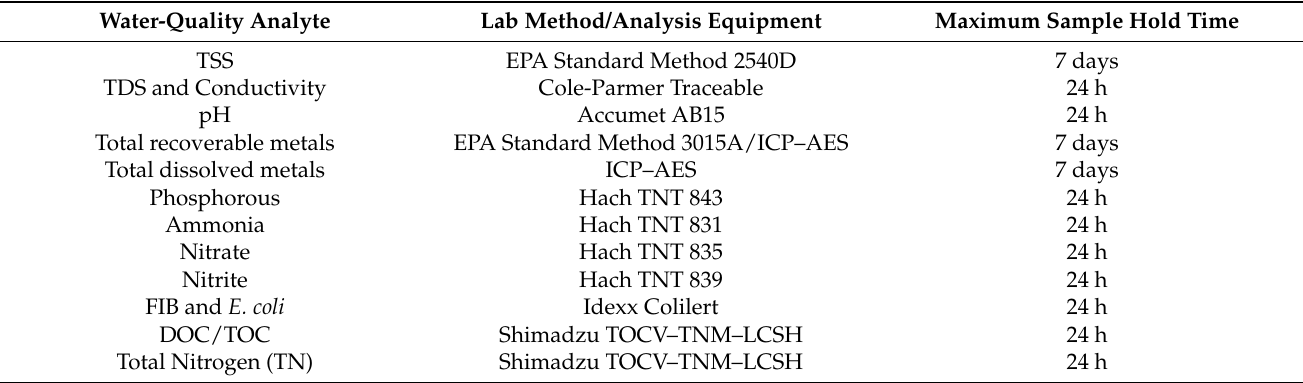
Table 2. Analytical methods and hold